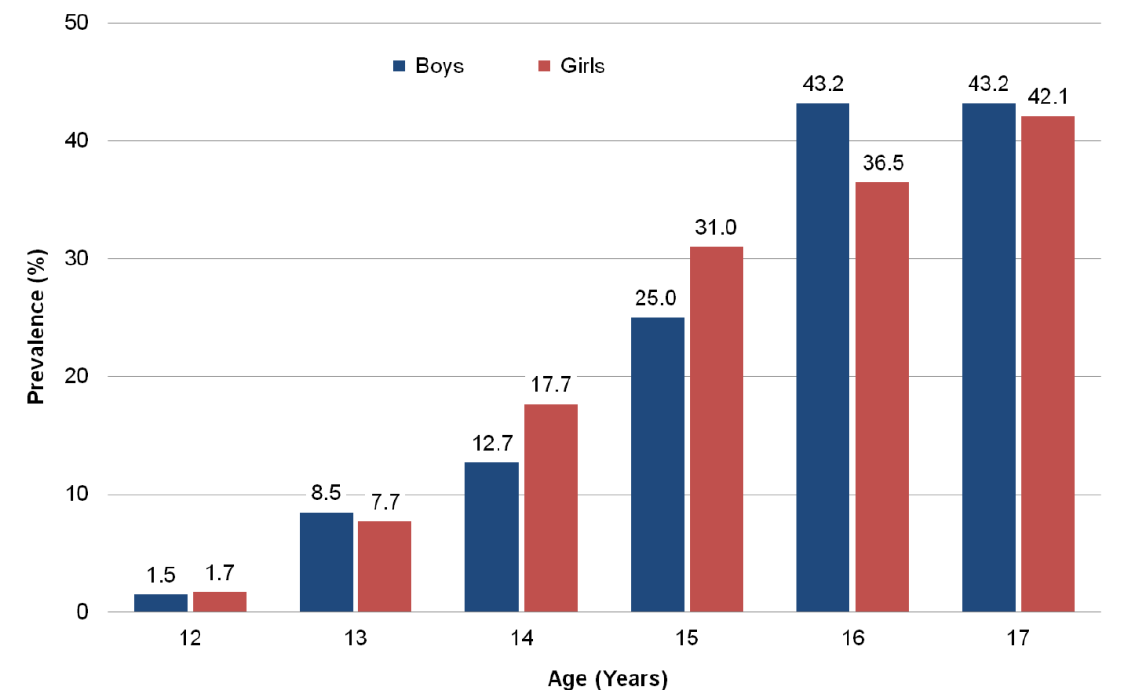
Figure 2. Smoking prevalence by gender and age among 12- to 17-year-old adolescents in Germany (KiGGS 2003–2006; n =